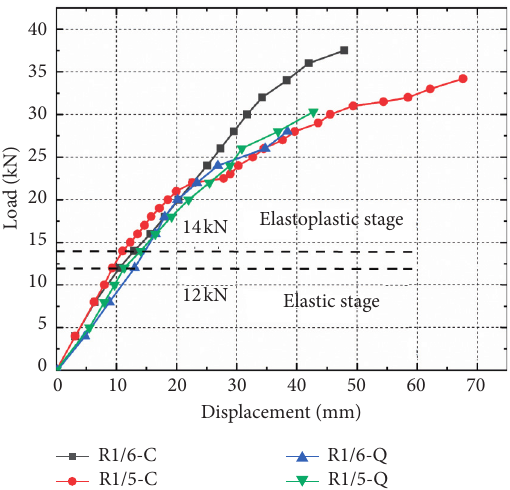
Figure 5: Load-displacement curves of glulam arch specimens.